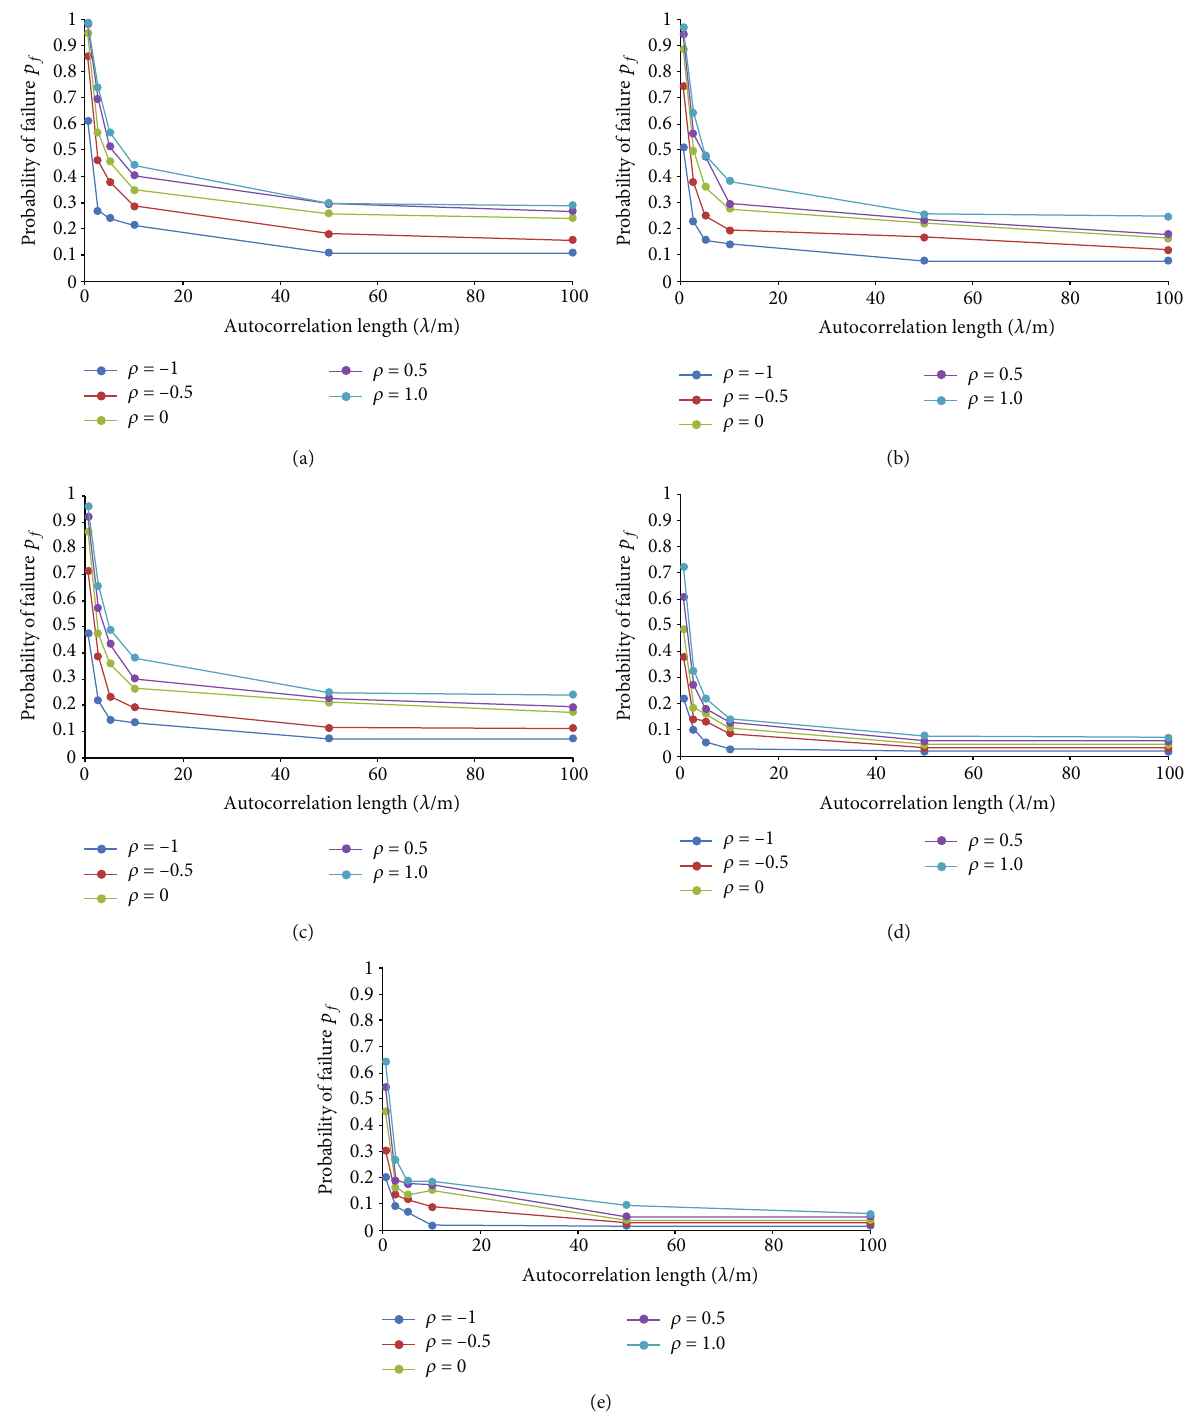
Figure 6: Probability of failure for di ff erent soils: (a) no suction; (b) sandy soil; (c) fi ne-grained soil; (d) clays; (e) extremely fi ne-grained